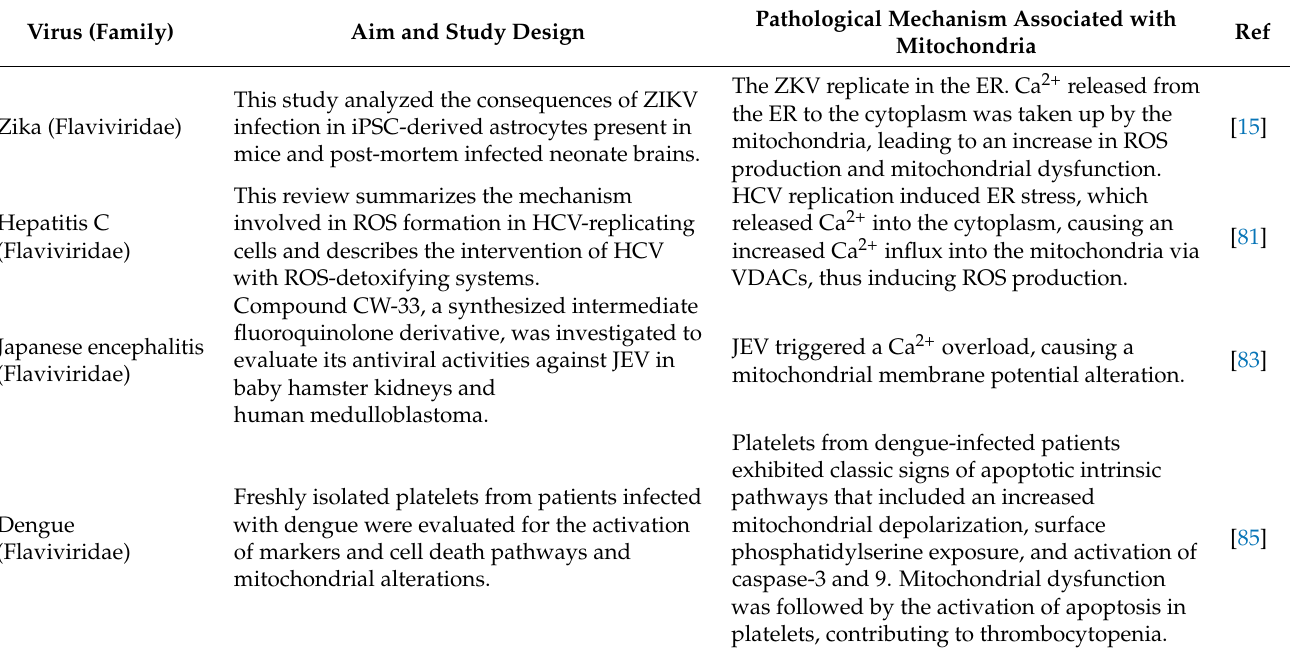
Table 1. Mechanisms of mitochondrial damage in multiple viral